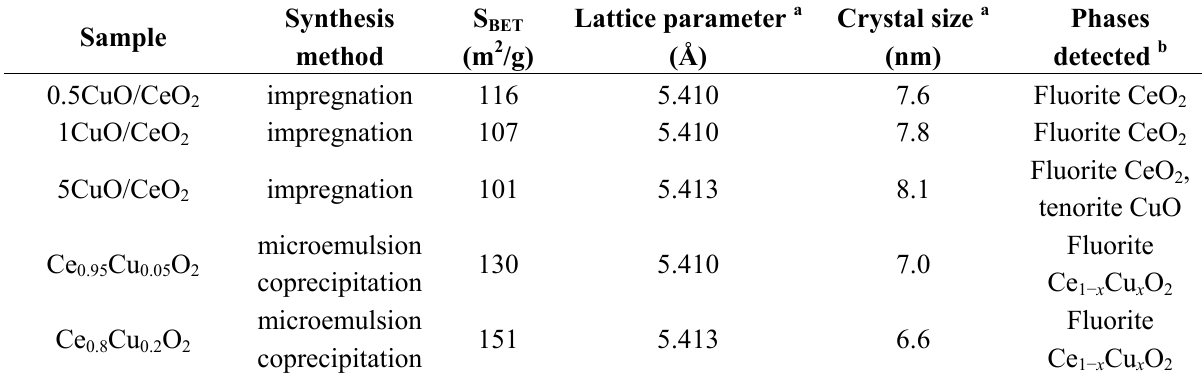
Table 1. Main textural and structural characteristics of the indicated copper-ceria